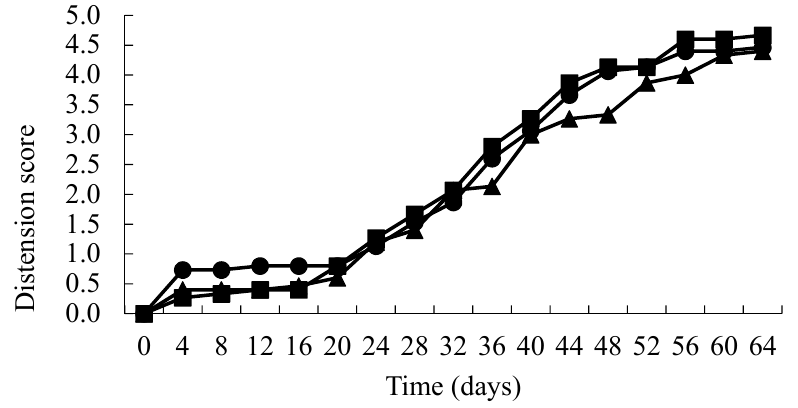
Figure 2. Distension status over time (days) of vacuum packs inoculated with spores of C. estertheticum and packaged in films containing 0 × MIC ( ▲ ), 2.5 × MIC ( ● ) and 3.5 × MIC ( ) IMDA.